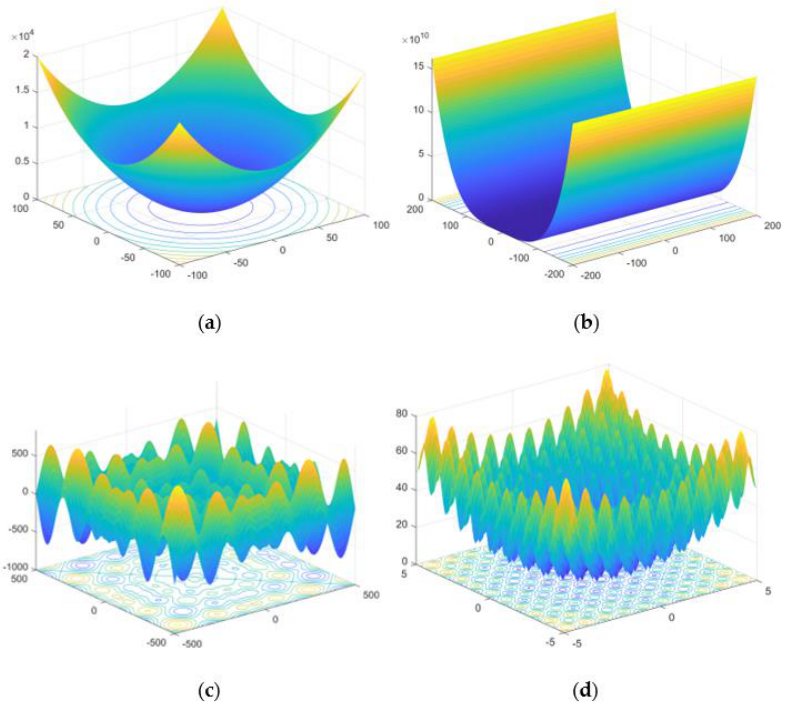
Figure 8. Standard test function: ( a ) sphere function; ( b ) Rosenbrock function; ( c ) Schewfel function; ( d ) Rastrigin function.